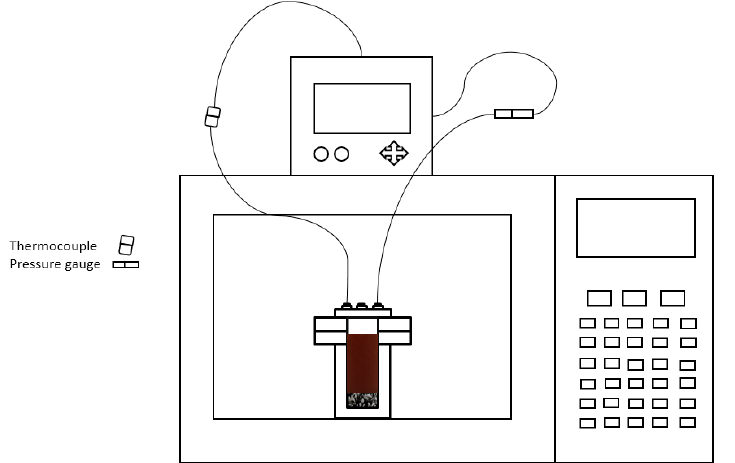
Figure A1. Experimental set up of HTC into gas-chromatography (GC) oven.